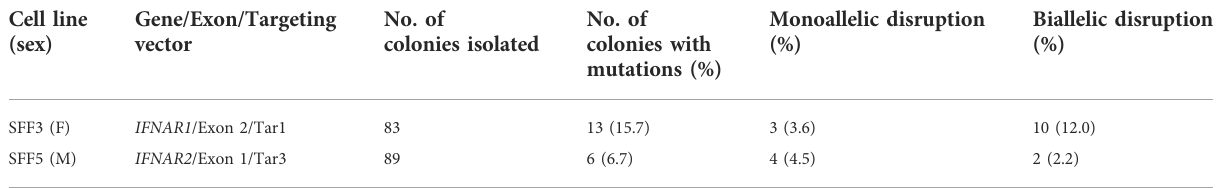
TABLE 3 Characterization of fi broblast colonies with mutations in IFNAR1 or IFNAR2